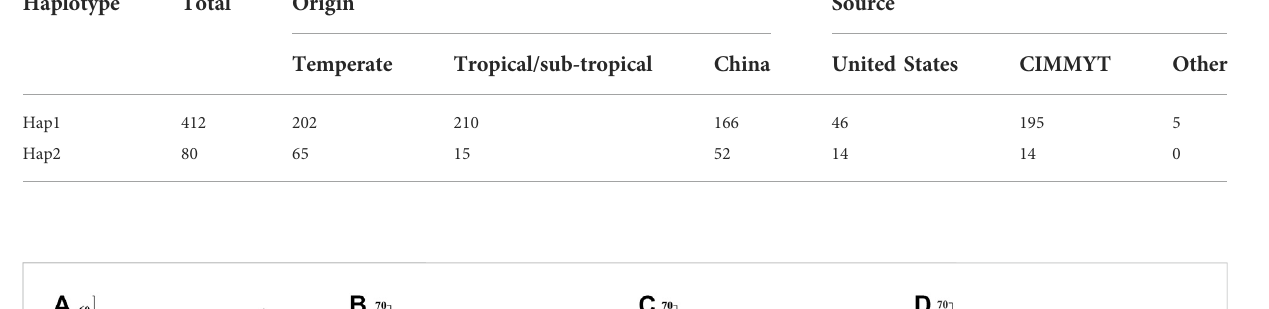
TABLE 4 The number of haplotypes for ZmULA1 in 492 maize inbred lines classi fi ed by origin and source, respectively. Haplotype